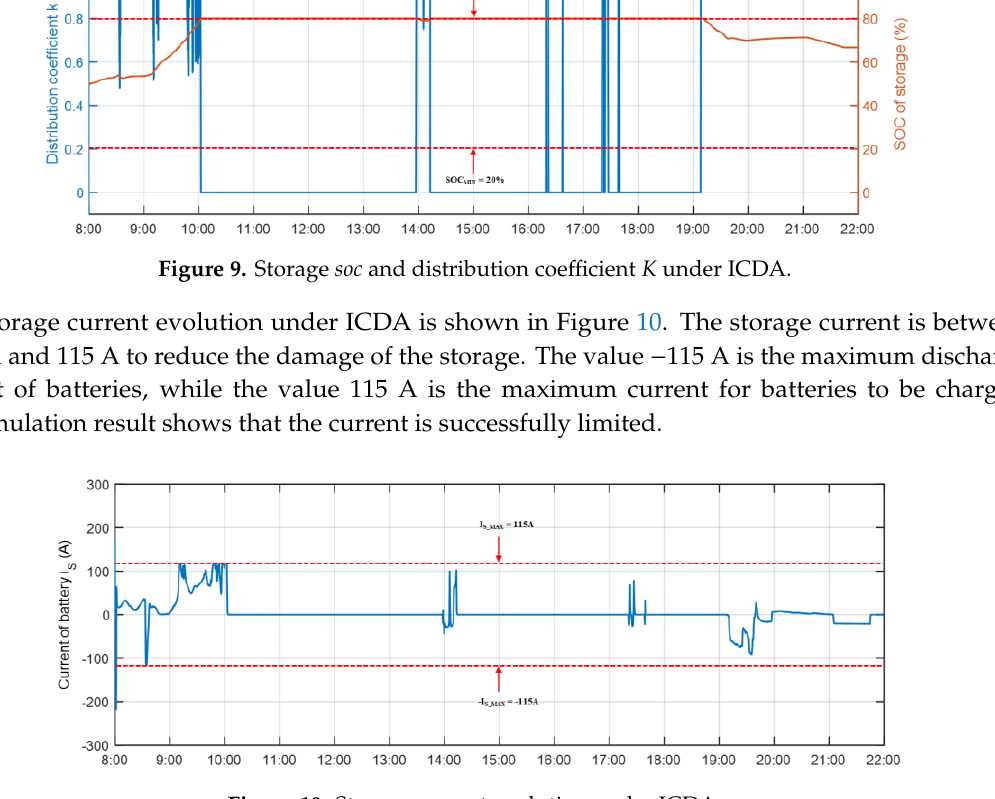
Figure 10. Storage current evolution under ICDA.